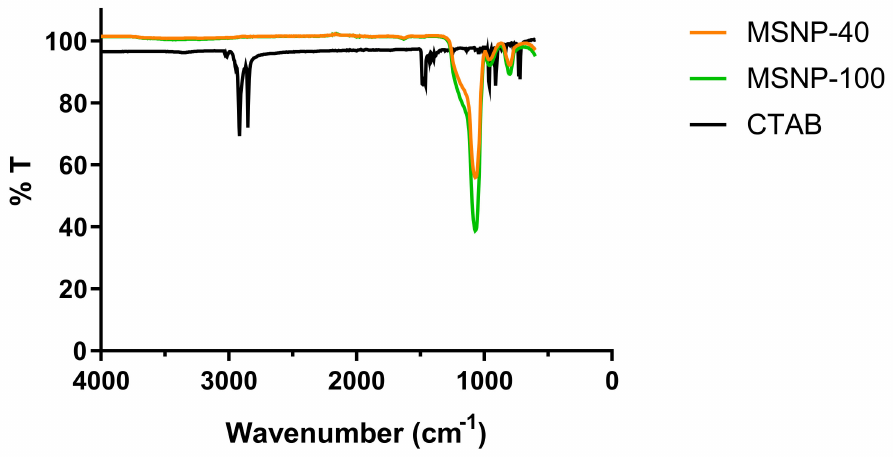
Figure 2. Fourier transform infrared (FTIR) spectra of MSNP-40, MSNP-100, and cetyltrimethyl ammonium bromide (CTAB) following solvent